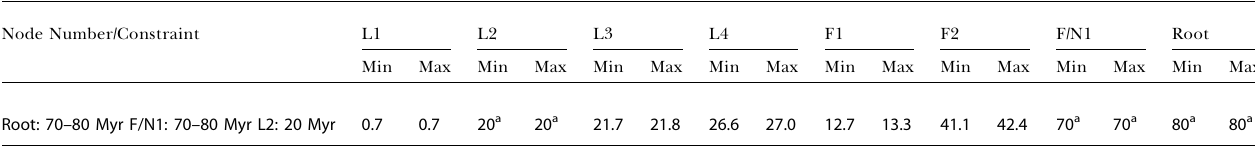
Table 3. Variation of Estimated Divergence Times (in Myr) under 60 Symmetrical Models of DNA Substitution Node Number/Constraint